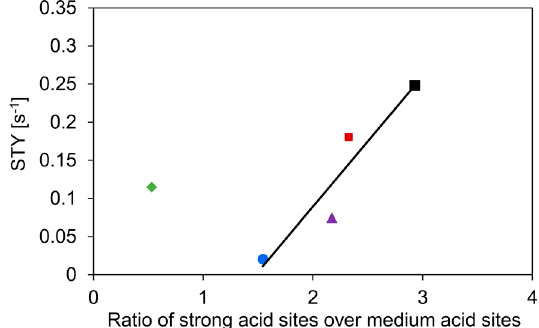
Figure 6. Site time yield (STY) as a function of the ratio of the amount of strong acid sites over medium acid sites. Symbols: c-HZSM-5 ( , black), n-HZSM-5 ( , red), PM-50/50 ( , purple), Hybrid-50/50 ( , green), and γ -Al 2 O 3 ( , blue). Temperature = 513 K, inlet pressure of n-butanol = 29 kPa, total pressure = 5 bar.